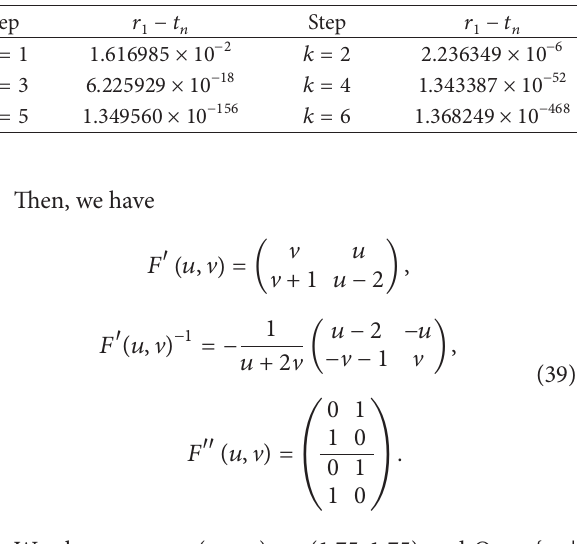
Table 1: Error results for Corollary 6 (‖𝑥 𝑛 − 𝑥 ∗ ‖ ≤ 𝑟 1 − 𝑡 𝑛 ) . Table 2: Error results for Corollary 6 (‖𝑥 𝑛 − 𝑥 ∗ ‖ ≤ 𝑟 1 − 𝑡 𝑛 ) .